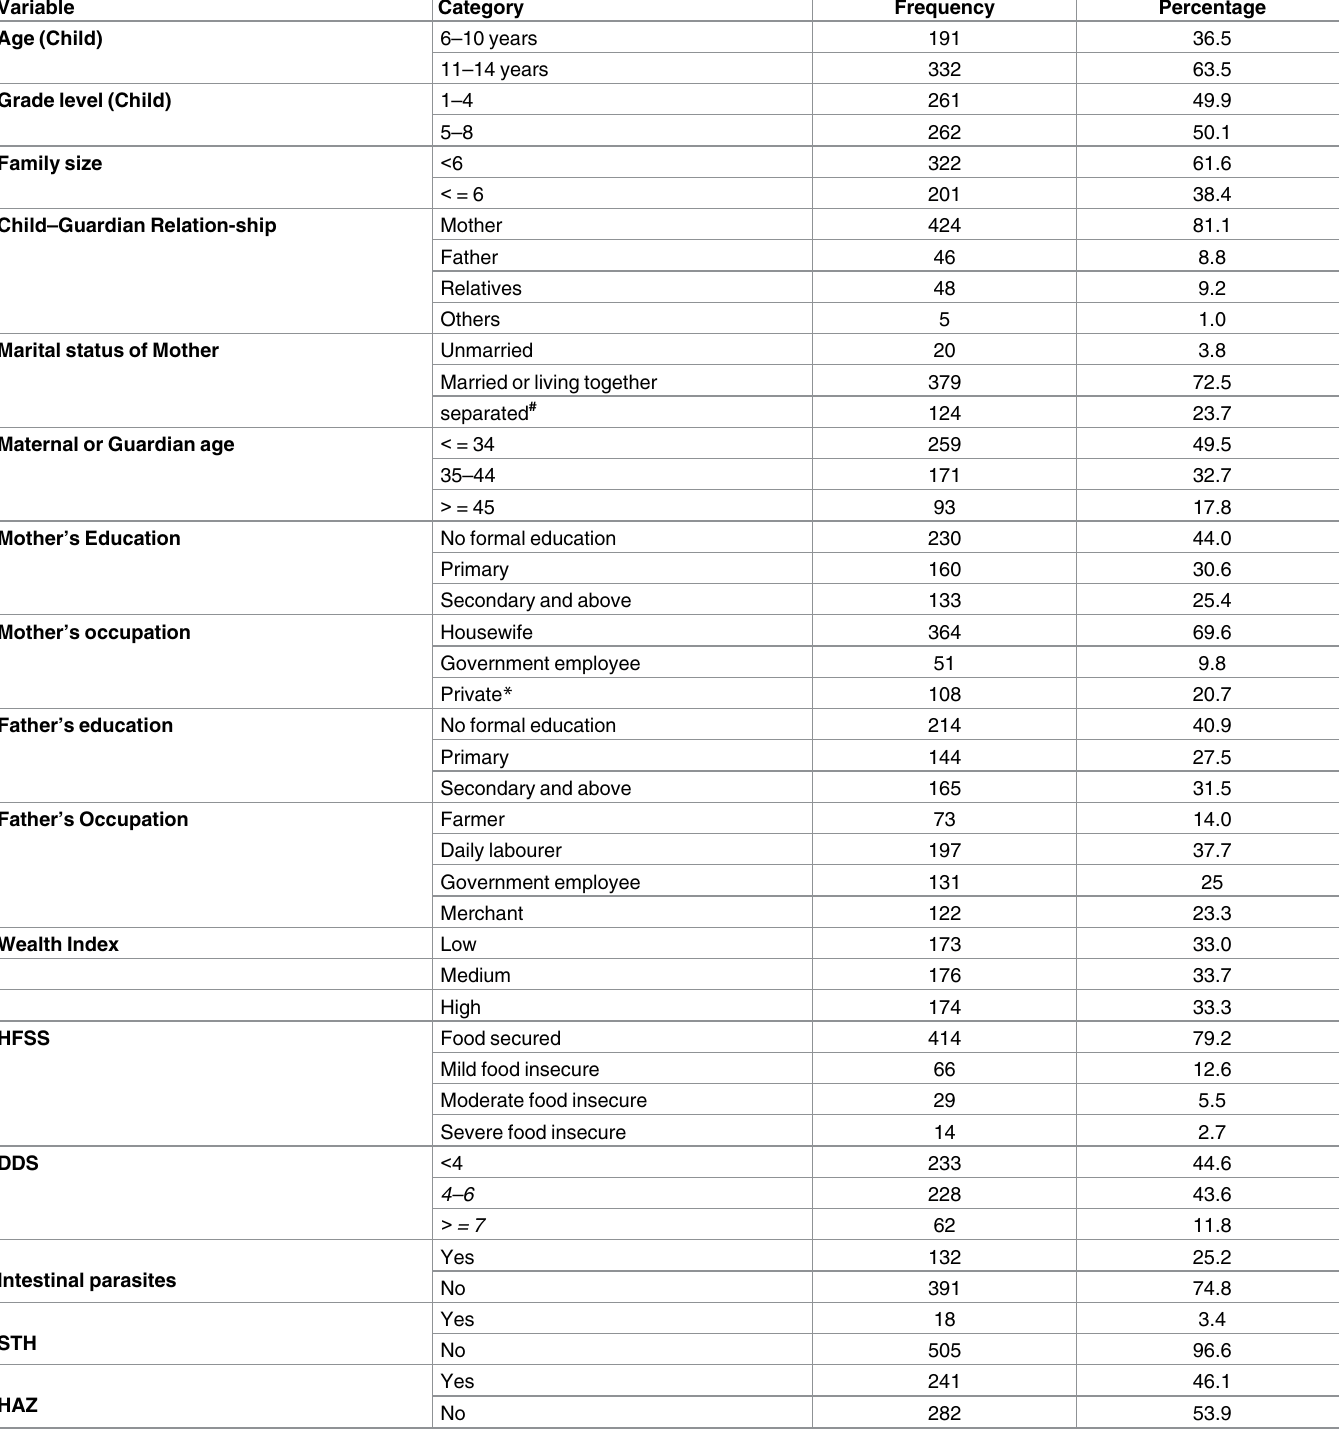
Table 1. Socio-demographic and other selected characteristics of SC and their parents, attending at public primary schools in Gondar town, Feb- ruary to May 2017(N =